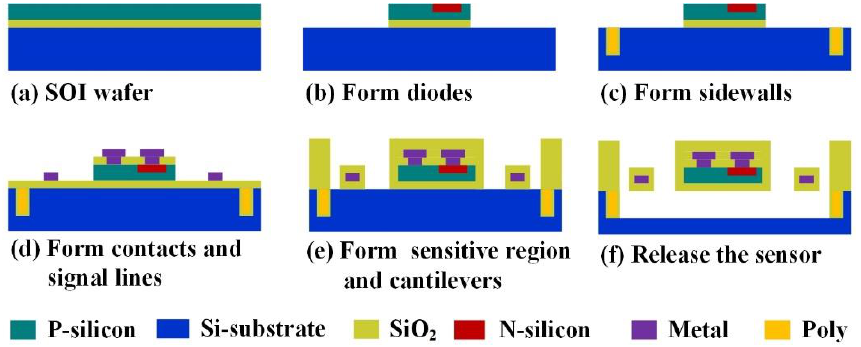
Figure 8. Fabrication process of the micro-Pirani vacuum sensor.